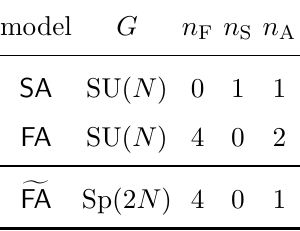
Table 1 . Three N = 2 superconformal models of class